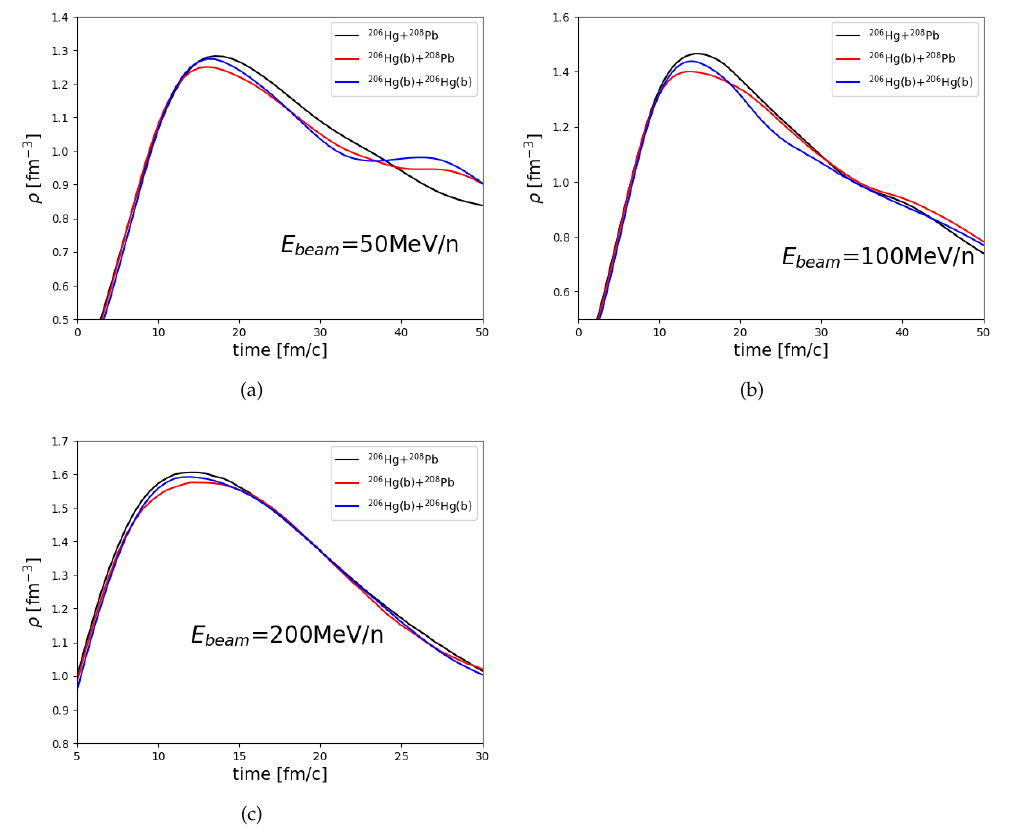
Figure 4. The densities at the collision center at E beam = 50 ( a ), 100 ( b ) and 200 ( c ) A MeV when the impact parameter is 3 fm. The black, red and blue lines are for 206 Hg (nonbubble) + 208 Pb, 206 Hg (bubble) + 208 Pb and 206 Hg (bubble) + 206 Hg (bubble) systems,